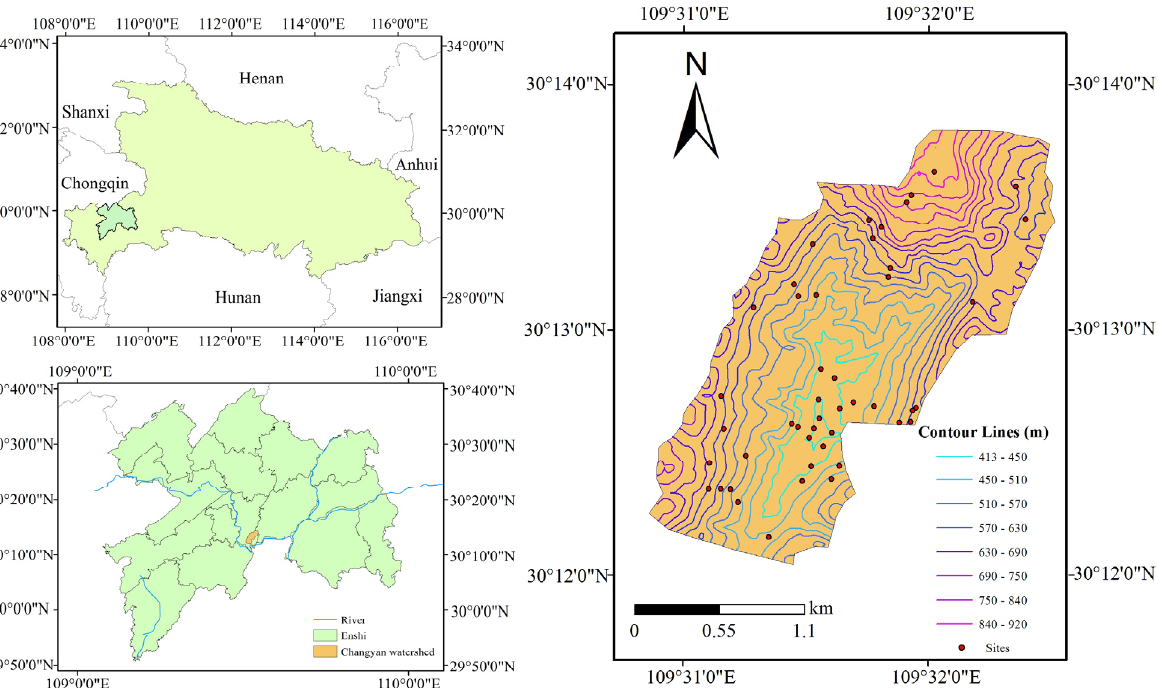
Figure 1. Location, topographic contour map, and sampling sites of the study area.